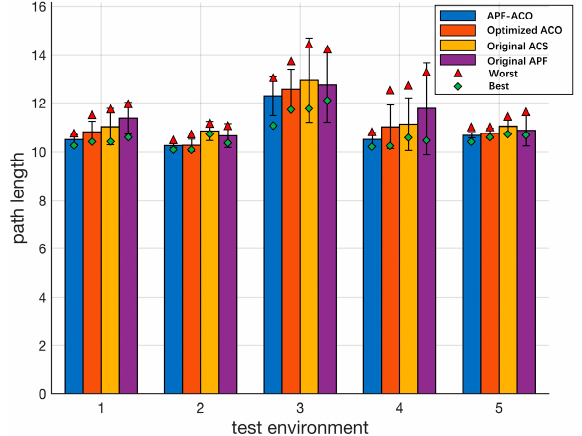
Figure 11. Statistical significance test results. Table 4. Comparison of the Results Obtained by the Four